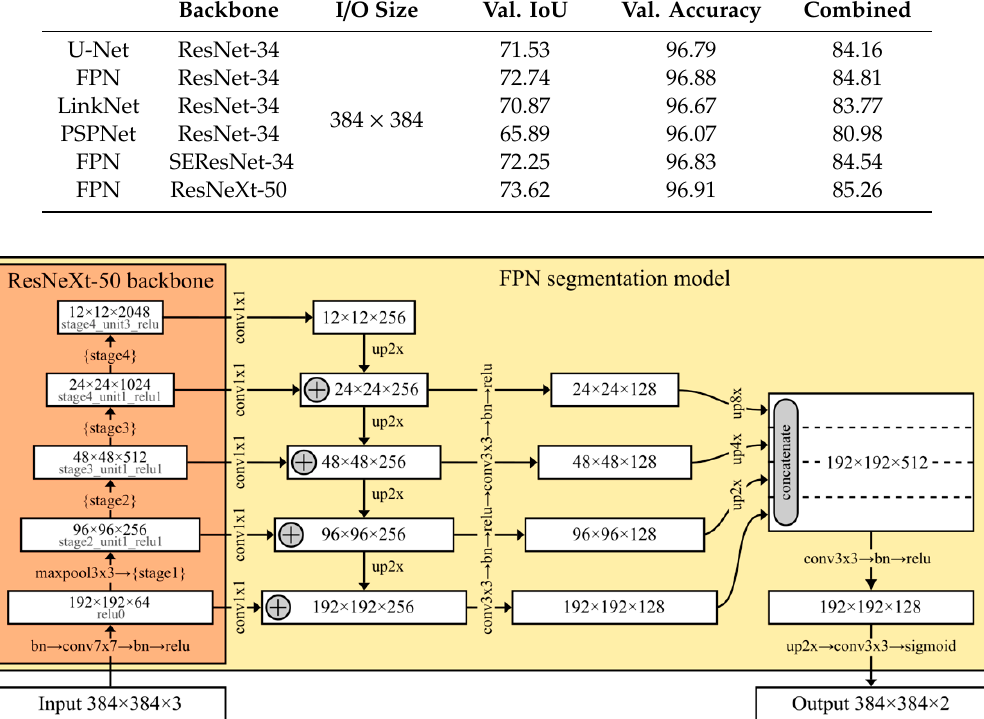
Figure 7. A detailed illustration of the used segmentation model based on FPN and ResNeXt-50. Table 1. Results of the preliminary study applied to select the architecture and backbone.